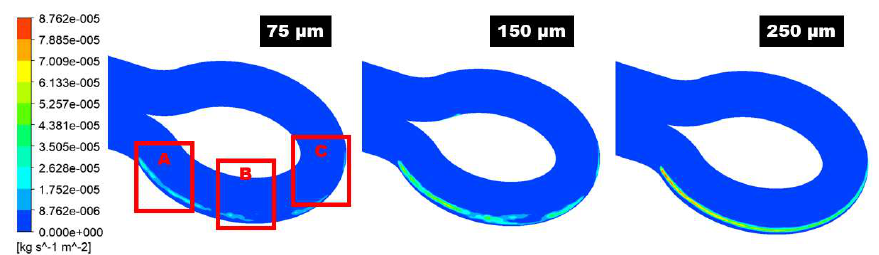
Figure 12. The contour of the erosion distribution in the double offset U-bend elbow under three different particle sizes.